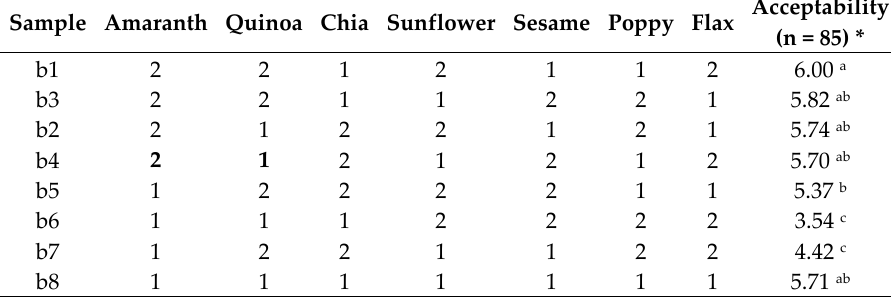
Table 2. Variables and experimental design response to the selection of ingredients.